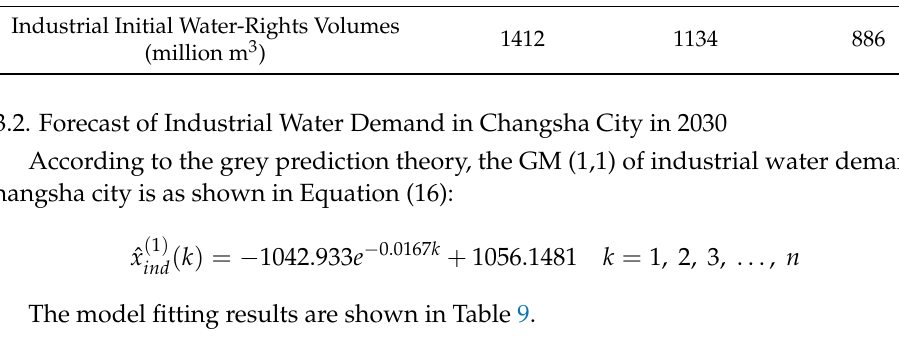
Table 8. Industrial initial water rights of Changsha city under different runoff frequencies in 2030. Runoff Frequency 50% 75% 90%